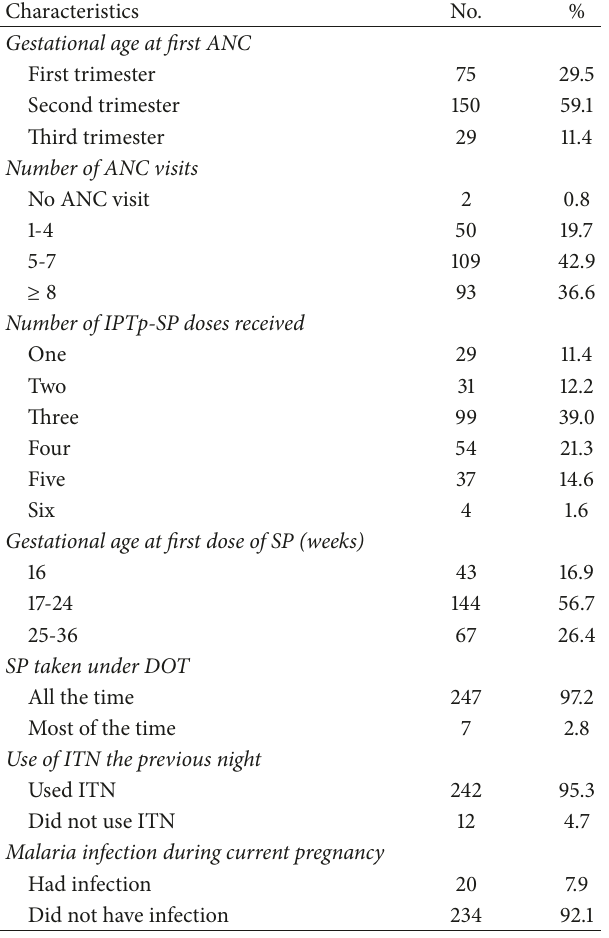
Table 2: ANC attendance, ITN use, IPTp-SP uptake, and malaria infection during current pregnancy by